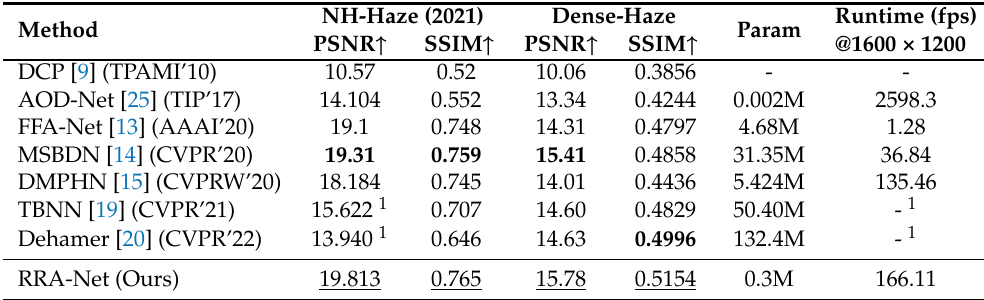
Table 1. Quantitative comparisons with SOTA methods on the realistic datasets. Best results are underlined. The second-best results are in Bold